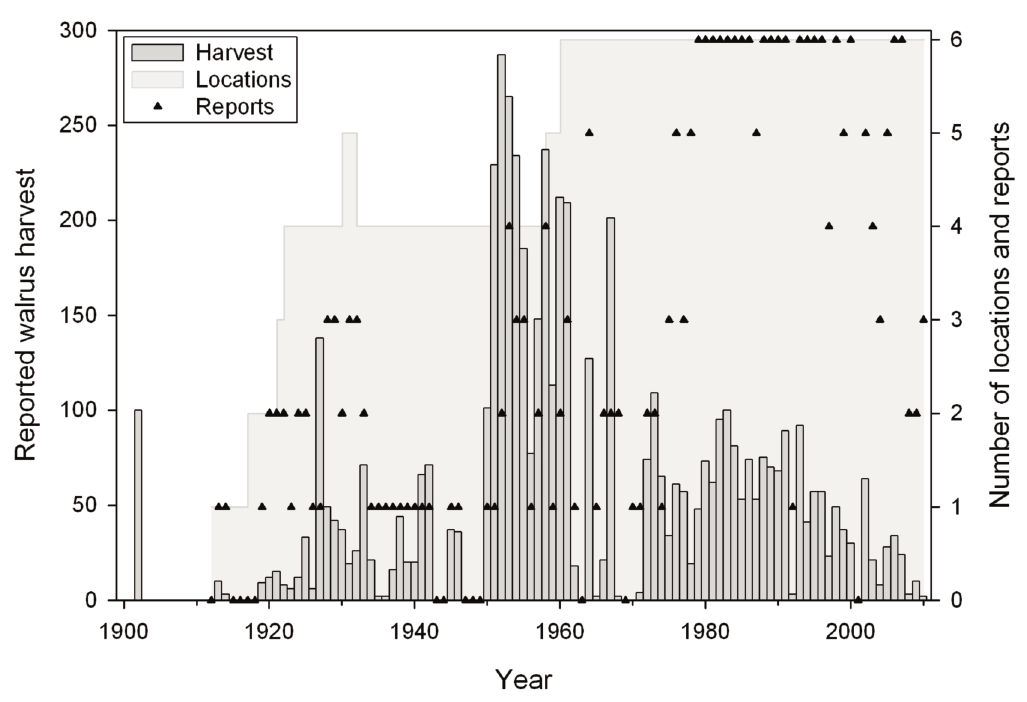
Fig. 21. Catches by Inuit and shore-based traders, and community reporting rates, from the North and West Hudson Bay (NWHB) stock of the Canadian Central Arctic walrus population, 1900–2010. Recent sport hunts not